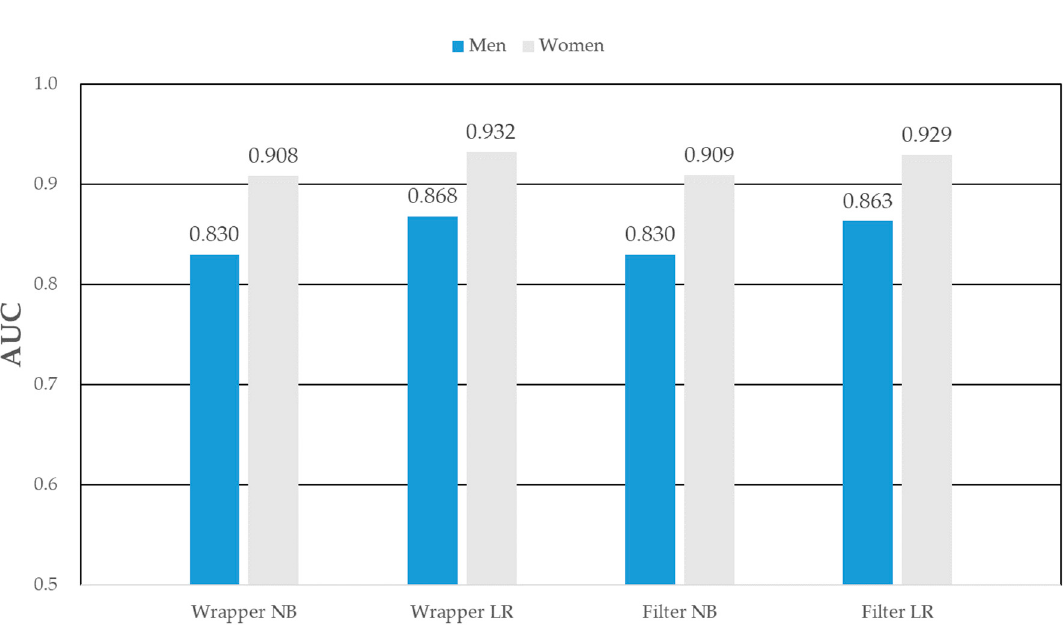
Figure 5. AUC of metabolic syndrome prediction models in men and women.